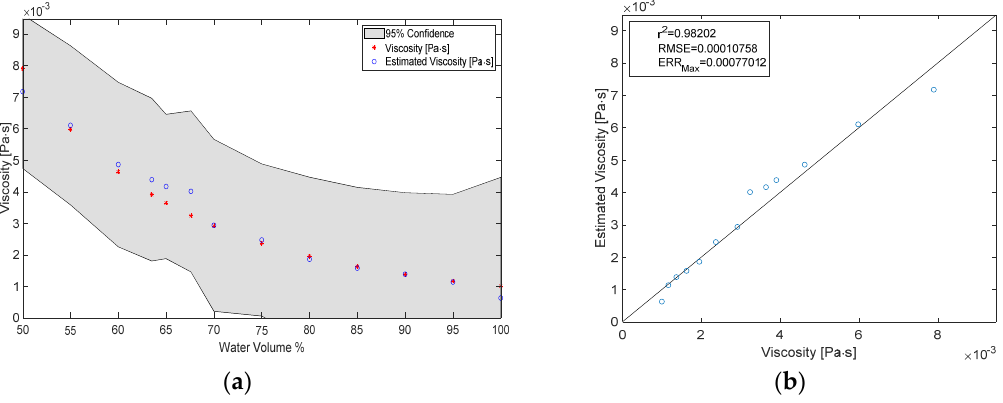
Figure 7. (a) Results of the viscosity estimation plotted versus volume fraction; (b) Fitness metrics of Figure 7. ( a ) Results of the viscosity estimation plotted versus volume fraction; ( b ) Fitness metrics of the estimation. the